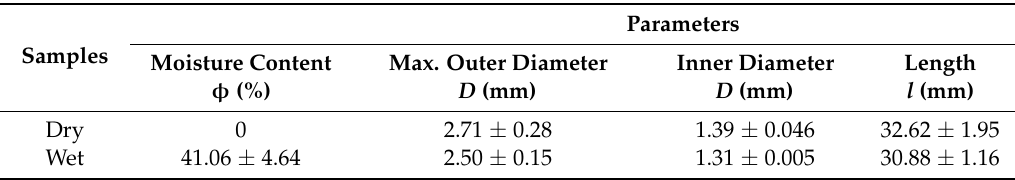
Table 2. Parameters of dactylopodite samples used for three-point bending tests.